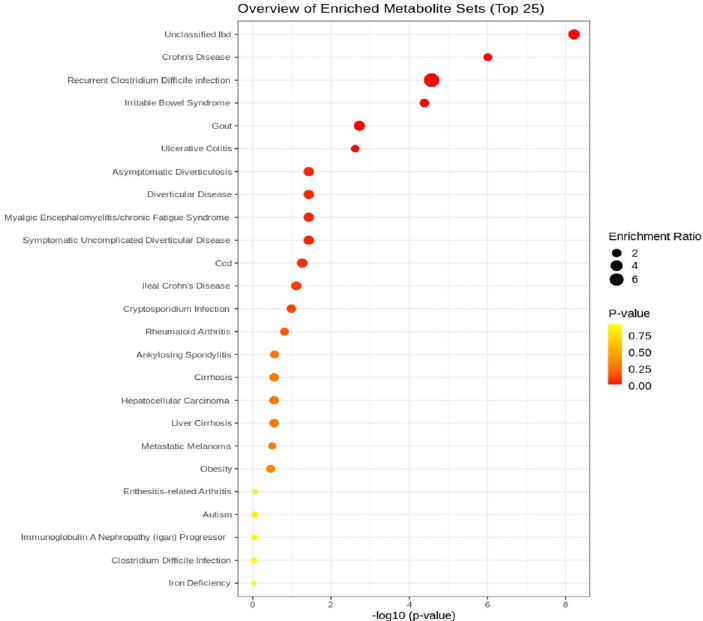
Fig 6. Metaboanalyst enrichment mapping of unique features identified by